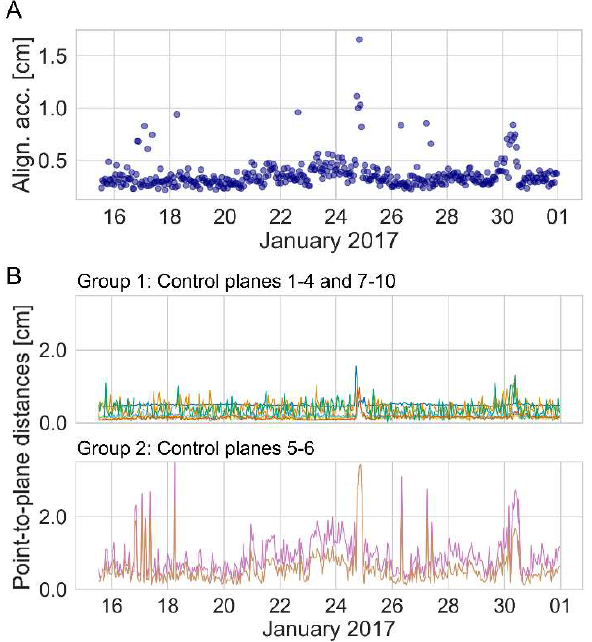
Figure 4. A) Alignment accuracy of hourly scans to the refer- ence point cloud. B) Mean absolute point-to-plane dista nces per control plane (distinguished by color) separated into two groups with (1) little variability, and (2) strong fluctuation of values